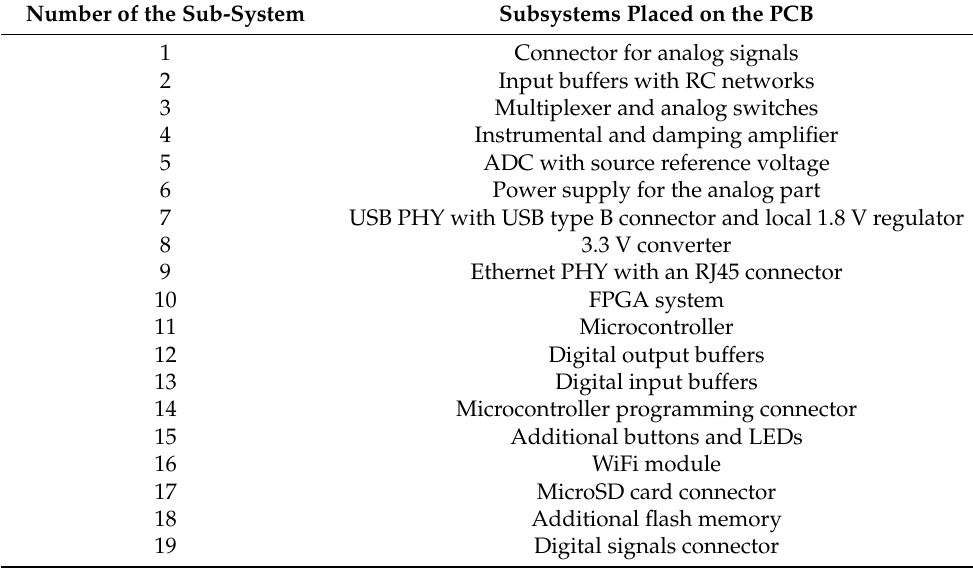
Table 3. Sub-systems placed on the PCB (Figure 7b).